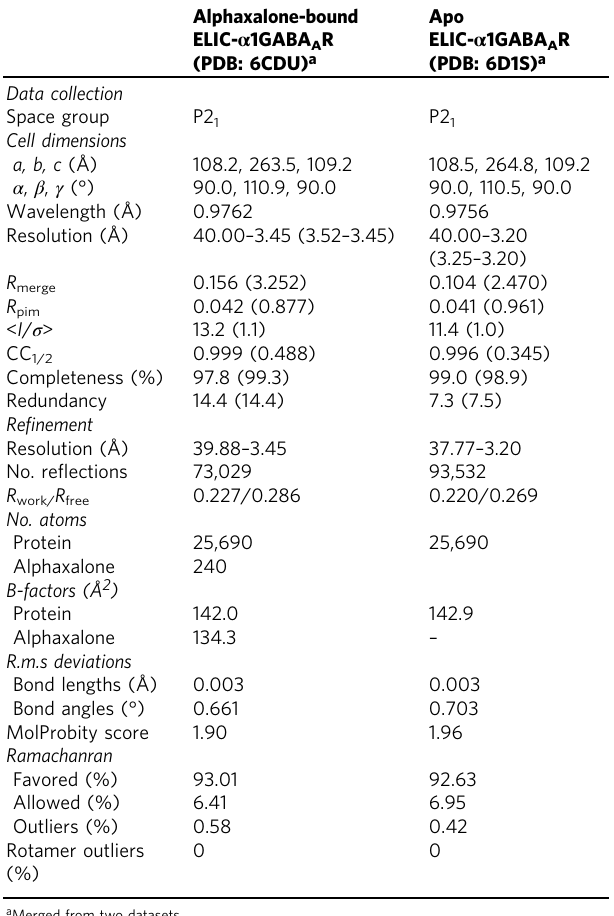
Table 1 Crystallographic data collection and re fi nement